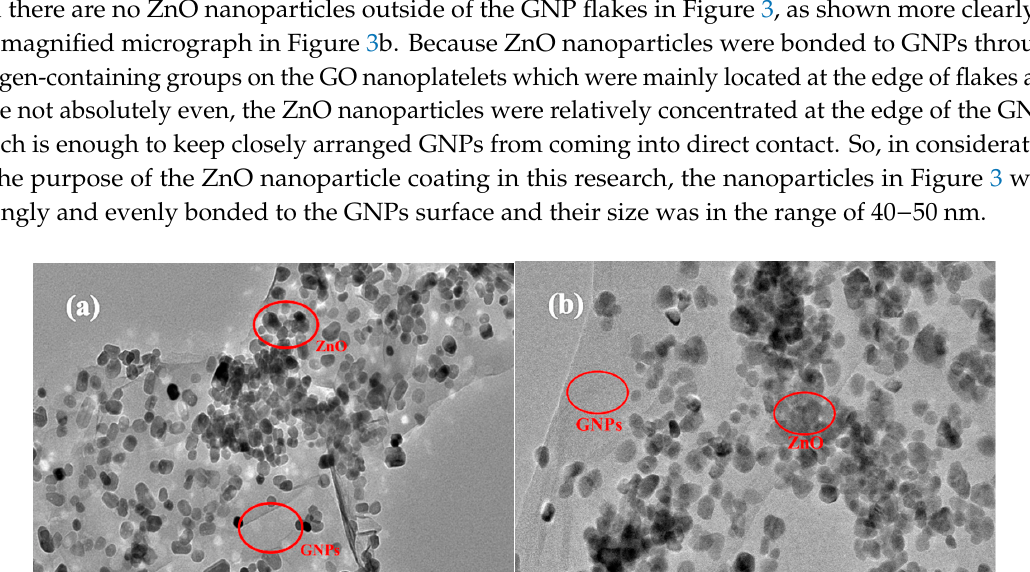
Figure 2. SEM micrograph ( a ) and EDS ( b ) of the GNP-ZnO hybrids powder.